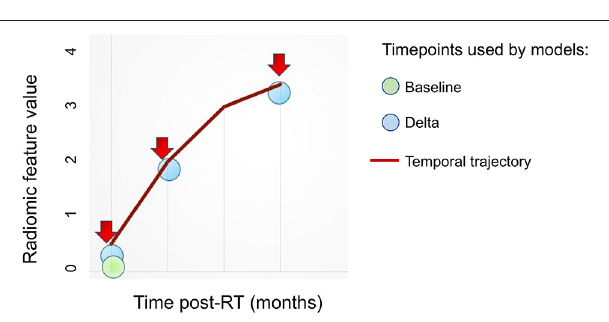
FIGURE 4 | Overview of radiomics features based approaches. Various approaches to integrate radiomics features obtained at multiple ( points toward building predictive models.